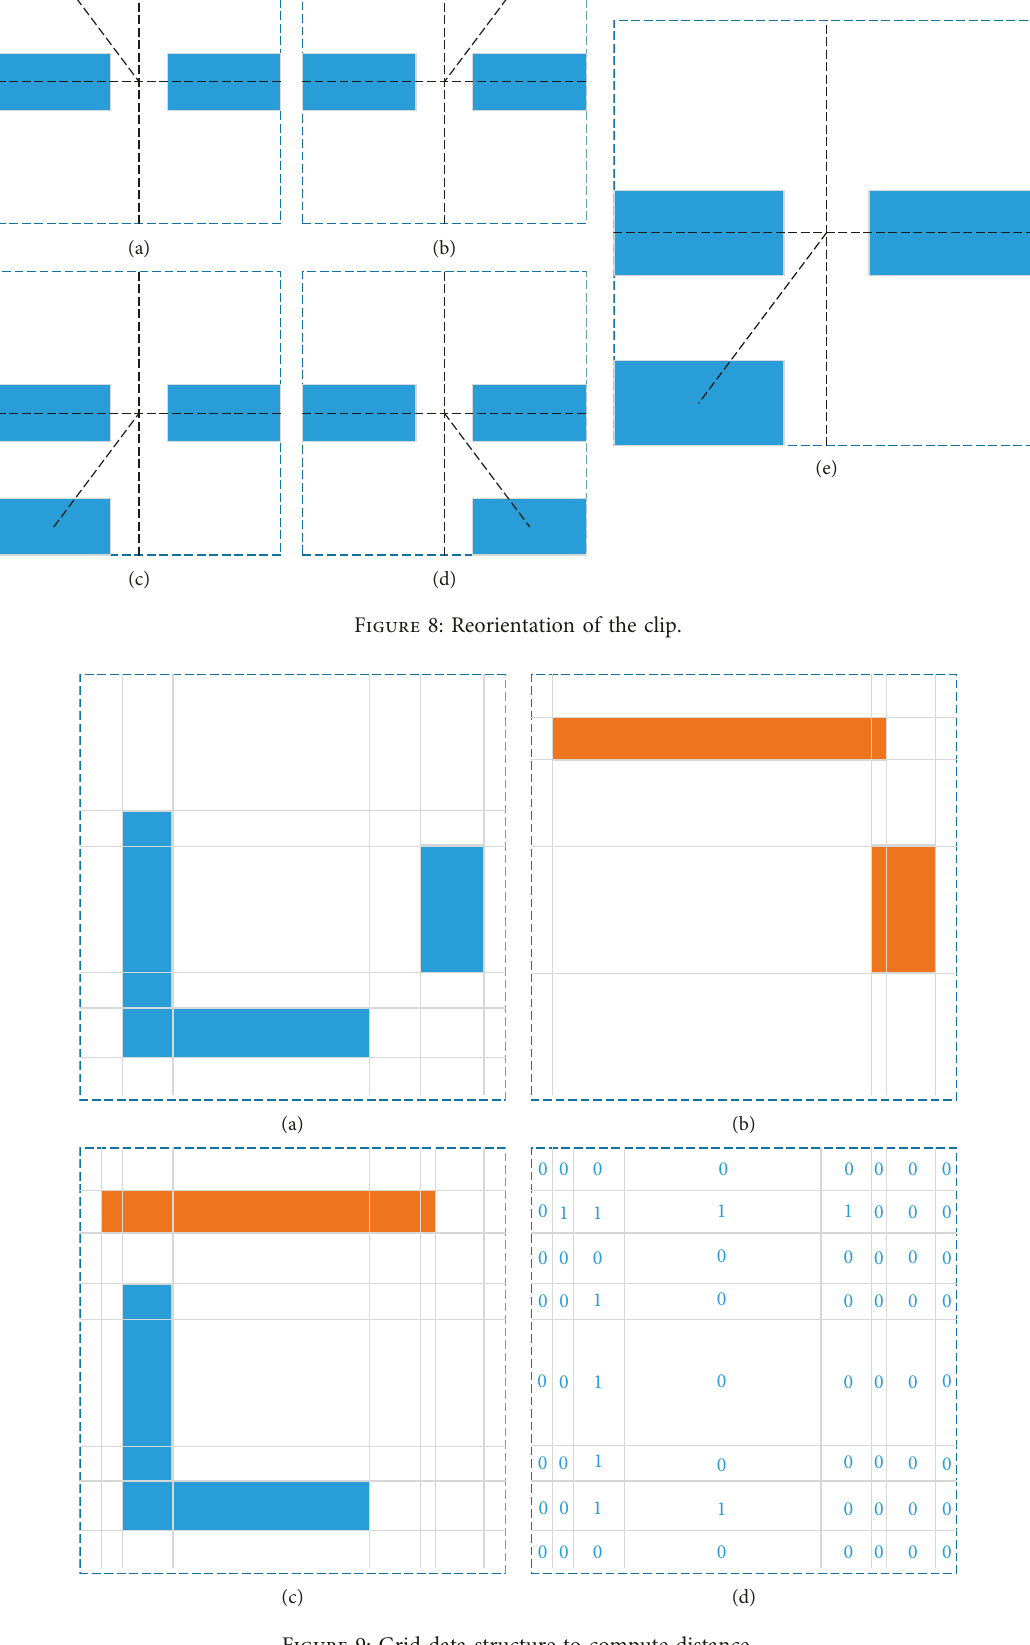
Figure 9: Grid data structure to compute